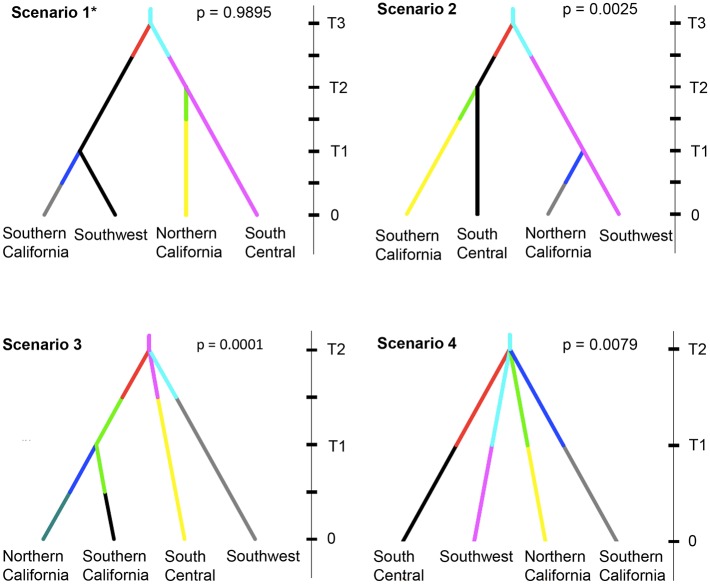
Colonization scenarios tested by DIYABC.Time is indicated on the y-axis. Time 0 corresponds to the present and time increases towards the past. The four figures show four different colonization scenarios, as described in the methods with their corresponding support values (“p” indicates the posterior probability of each scenario). Lineages are drawn in different colors. Changes in line color suggest possible changes in effective population size through time.